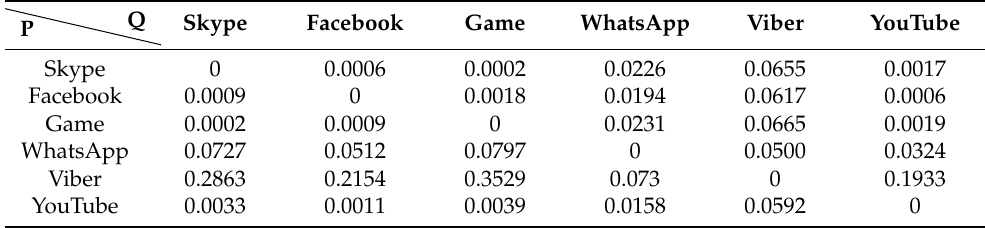
Table 14. Kullback–Leibler divergence of IAT probabilities.